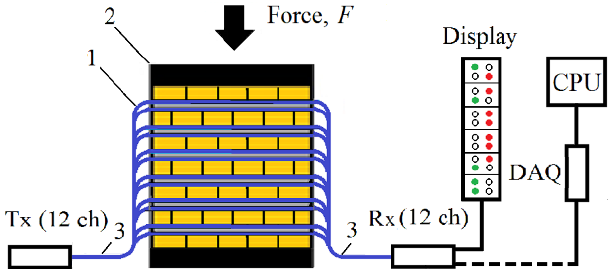
Figure 5. Schematic diagram of the opto-electronic monitoring system: (1) optical fibers; (2) test specimen; (3) array of 12 optical fibers for detection of structural cracks; Tx—optical transmitter, 12-channel; Rx—photoreceiver, 12-channel; DAQ—data acquisition module (multichannel analog-to-digital converter); CPU—computer central processing unit for storing the measured optical transmission in digital form; Display—an indicator of the structural damage in visual form.